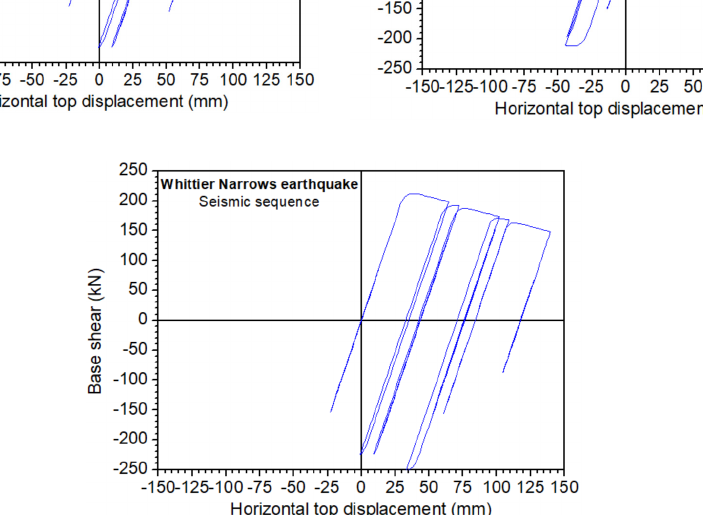
Figure 15. Fixed-base platform under the Whittier Narrows earthquakes (1 – 4 October 1987): single seismic events vs. seismic sequence.